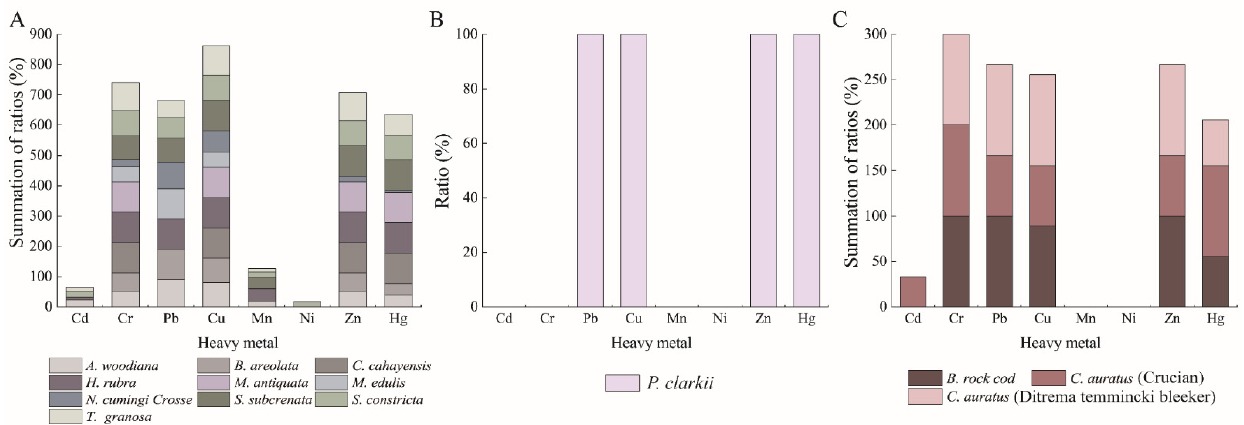
Figure 4. Heavy metal tolerance profiles of the 125 K. oxytoca isolates recovered from the14 species of aquatic animals. ( A ) mollusks; ( B ) crustacean; ( C ) fish.